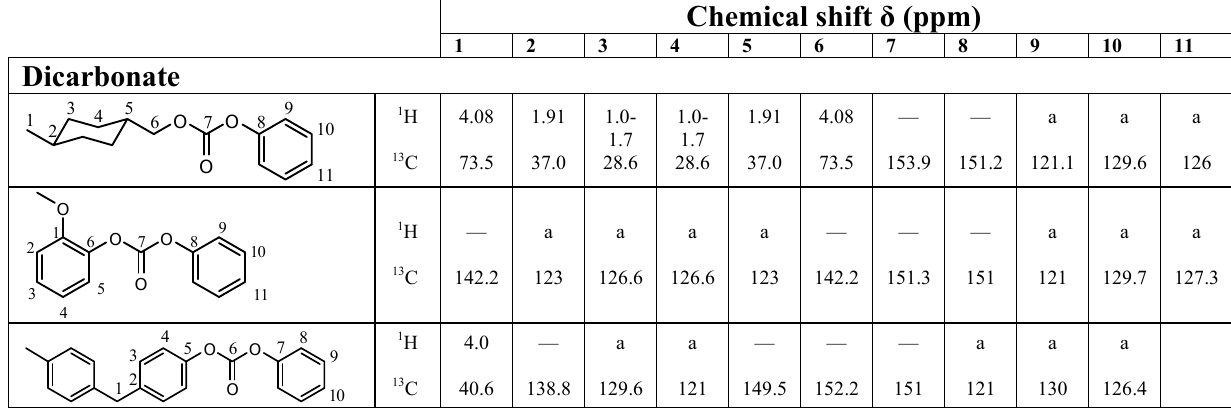
Table 2. 1 H and 13 C-NMR data for selected alkylene- and arylenediphenyl dicarbonates and diacetates. Chemical shift δ